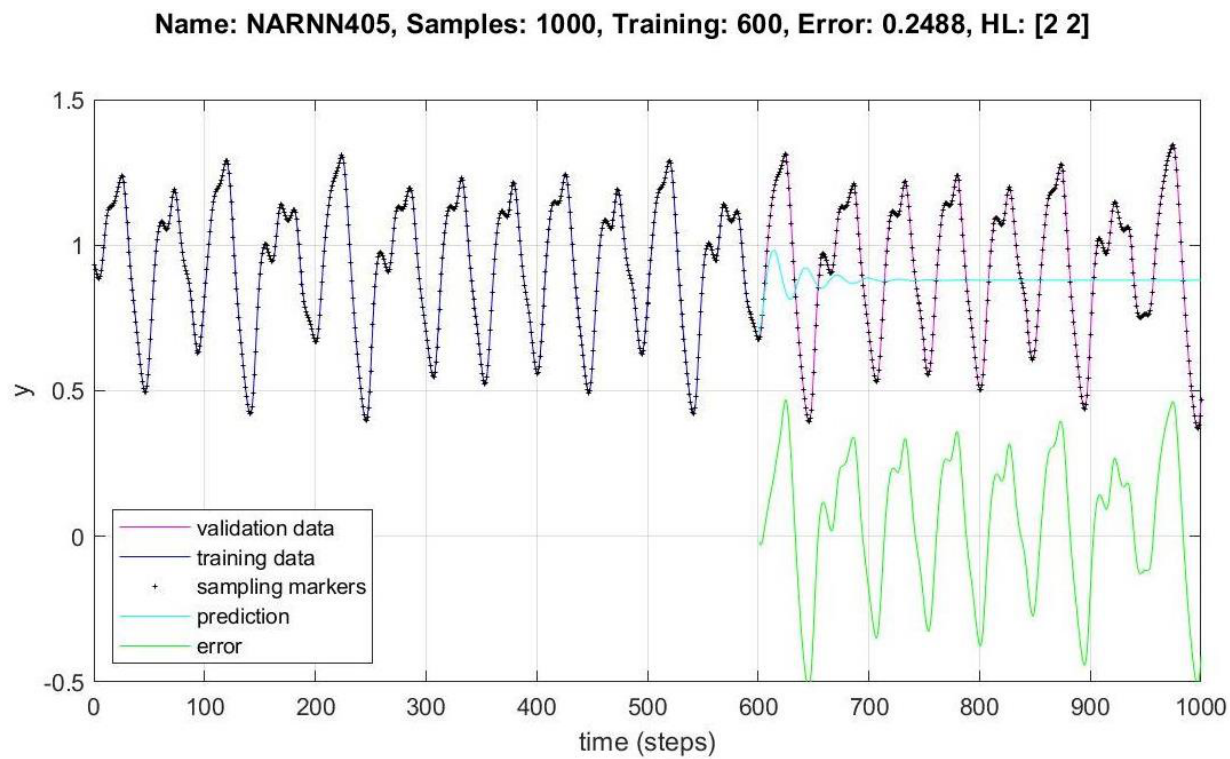
Figure 10. Performance of NARNN405 for 1000 samples.